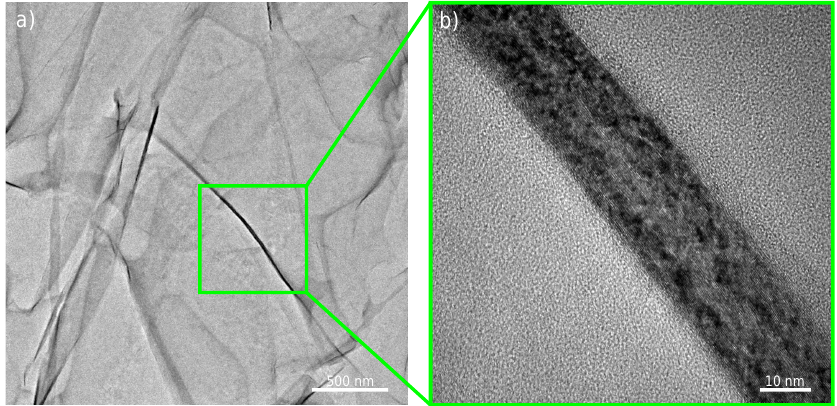
Figure A18. TEM images for ExG at ( a ) low magnification and ( b ) high magnification. Figures A19 and A20 give the TEM images of SWCNT Tuball 75 and Tuball purified, respectively. Both appear in a highly bundled state. The purified SWCNT offer low metallic impurity